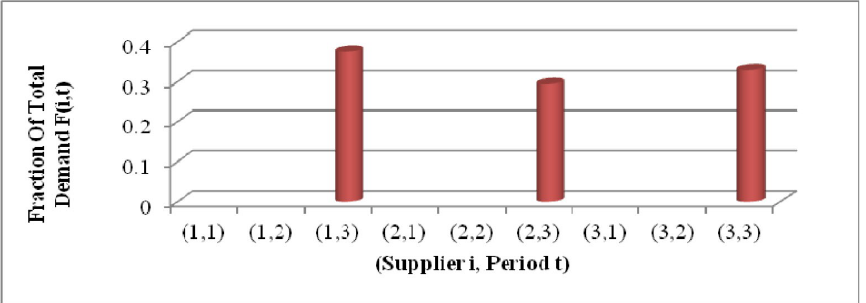
Figure 6. Supply portfolio for α=25%